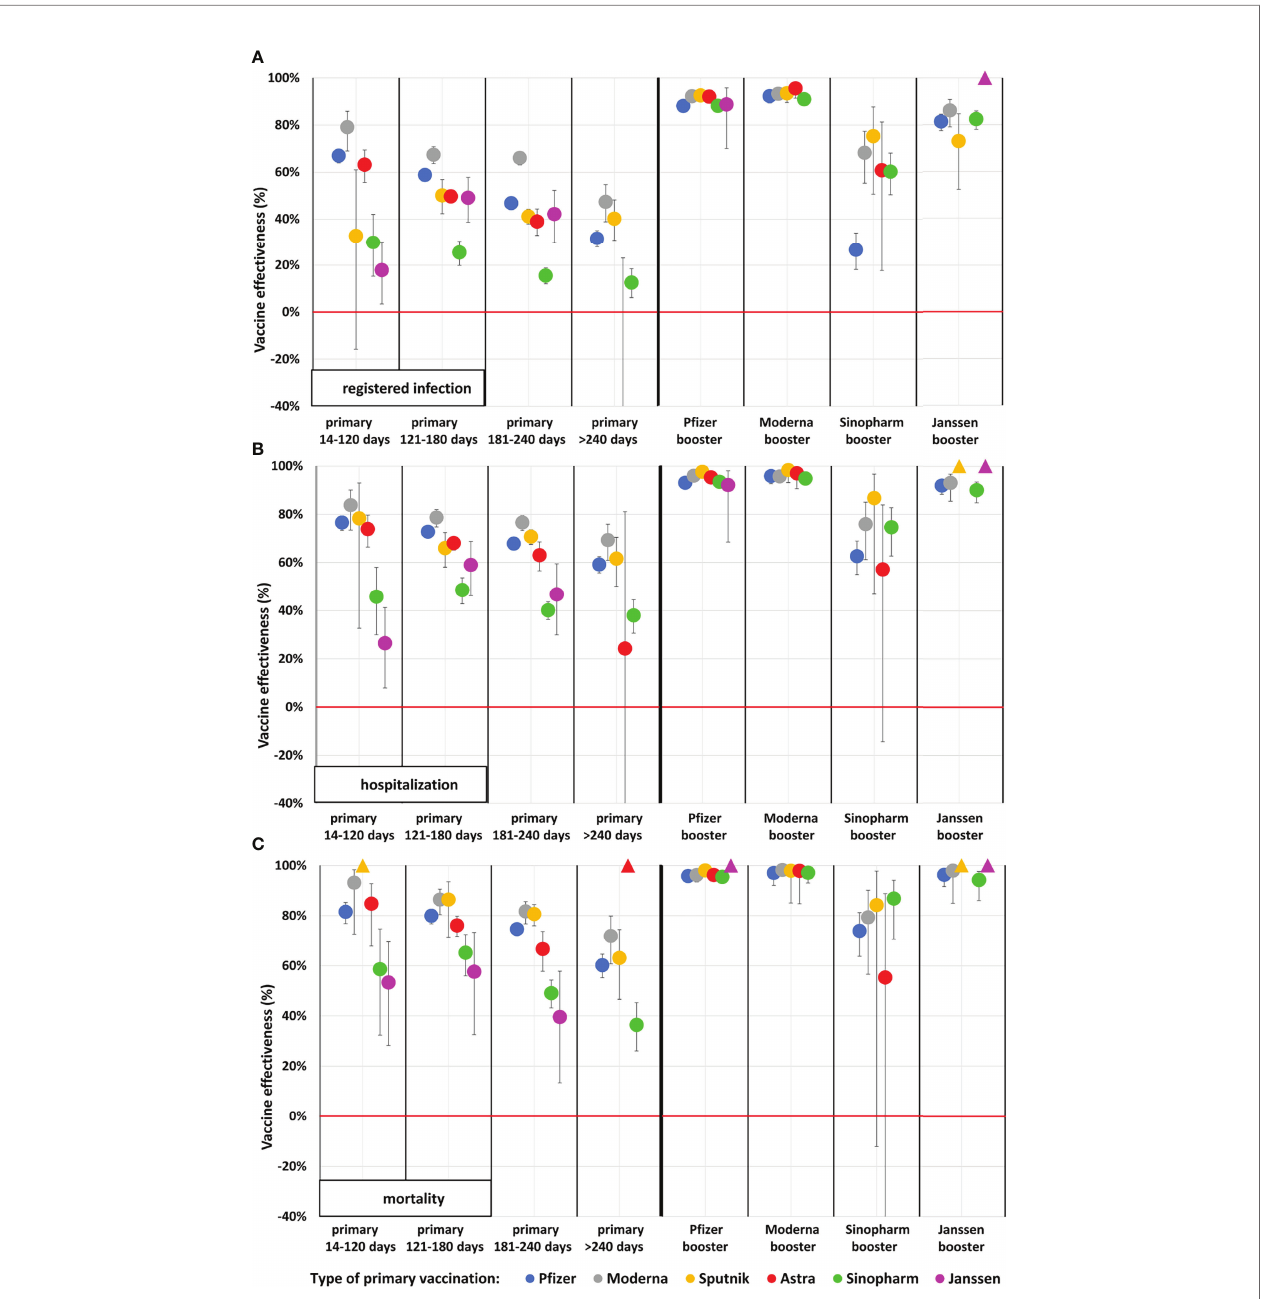
FIGURE 2 | Adjusted vaccine effectiveness against registered SARS-CoV-2 infection, Covid-19 related hospitalization and death during the Delta wave in the Hungarian population aged 65 – 100 years. (Data points marked with triangles at value 100% indicate vaccine combination categories where no outcome occurred. In these categories, the person-time of observation is very limited). (A) Registered infection, (B) Hospitalization, (C)